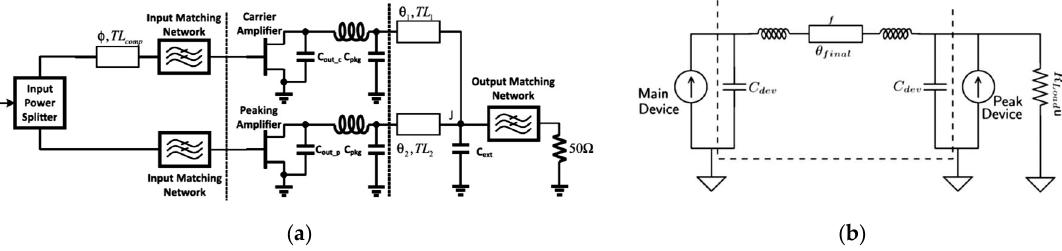
Figure 17. ( a ) Simplified scheme of broadband Doherty PA [95]. ( b ) Schematic of a DPA, which absorbs the device output capacitances and bond-wires into the quasi lumped transmission line impedance inverter [99].